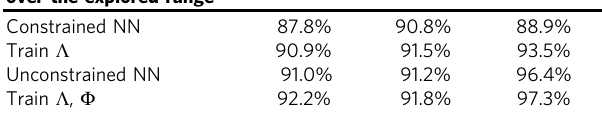
The best (average) performance of the different training schemes is